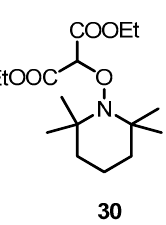
Figure 16. Structure of alkoxyamine 30 .